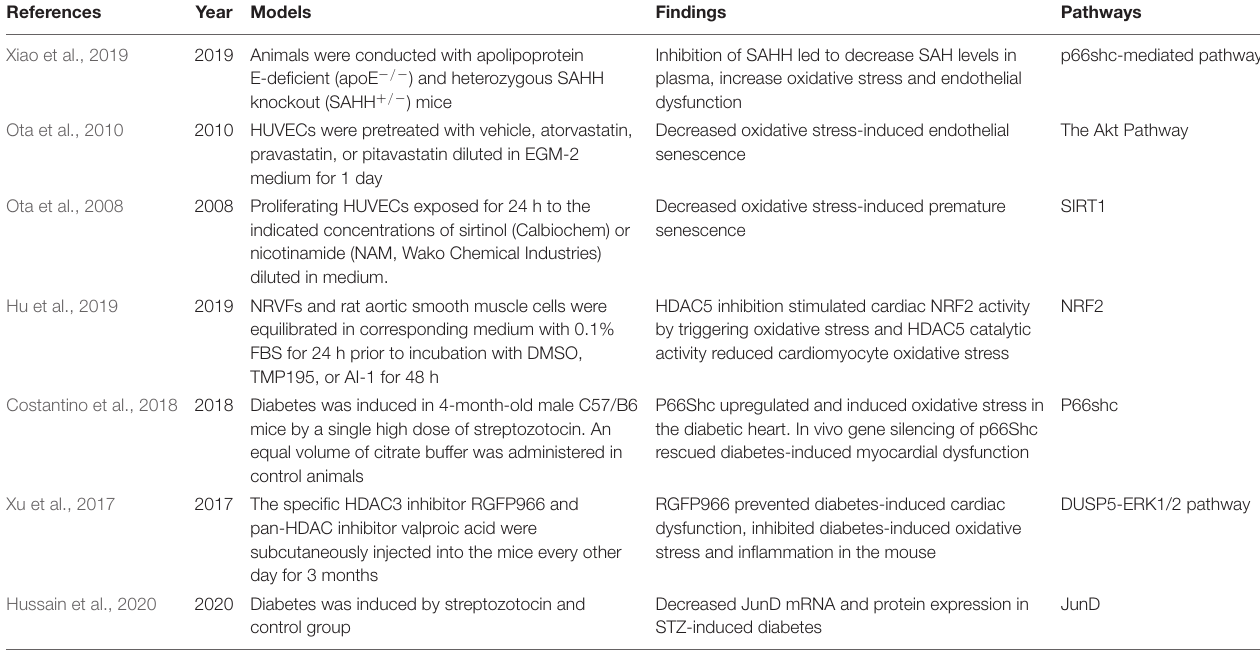
TABLE 2 | Experiments on the epigenetic regulators of oxidative stress